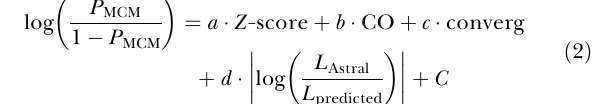
in Top30 with P MCM .